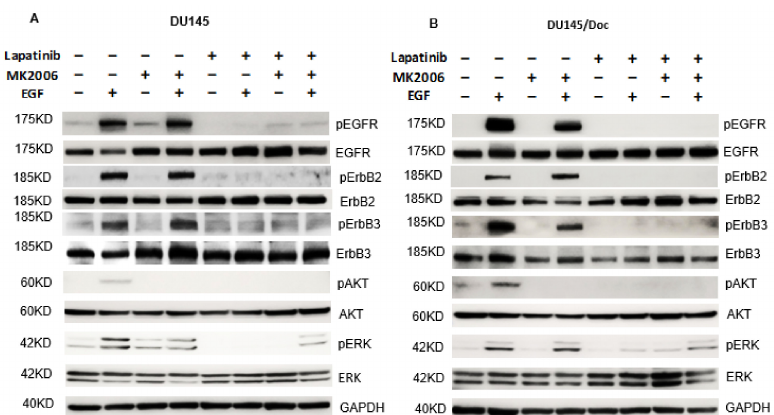
Figure 5. ErbB and downstream signaling in DU145 and DU145/Doc cells. Western blots. Cells were treated with DMSO, lapatinib (3 µ M), MK2206 (15 µ M) or both agents for 24 h, then, where indicated, with EGF (50 ng/mL, 10 min) before the cell harvest was conducted. Forty-five ug protein samples were loaded per well. ( A ) DU145, and ( B ) DU145/Doc. The uncropped blots are shown in Figures S13 and